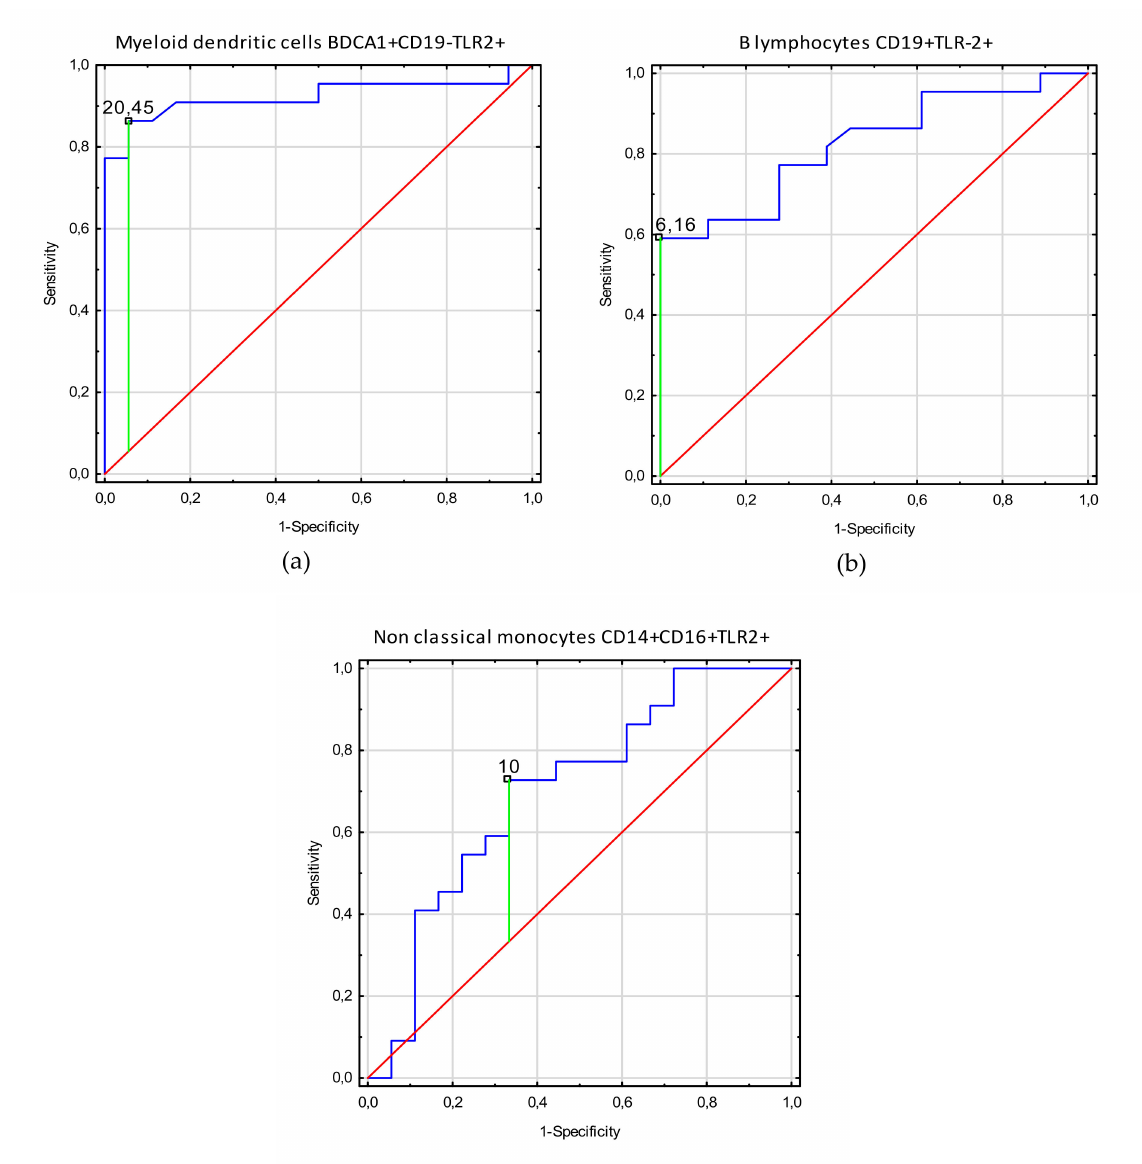
Figure 3. Receiver operating curve (ROC) analysis to determine diagnostic accuracy in di ff erentiation of endometriosis patients with and without adhesions: ( a ) frequencies of myeloid dendritic cells BDCA1 + CD19-TLR2 + [%]; ( b ) frequencies of B lymphocytes CD19 + TLR2 + [%]; ( c ) frequencies of non-classical monocytes CD14 + CD16 + TLR2 +